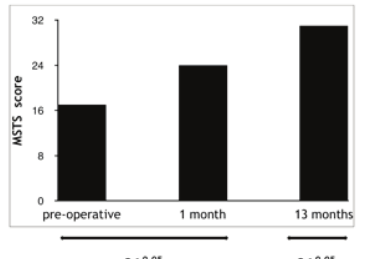
Figure 18: Significant improvement of MSTS score over the